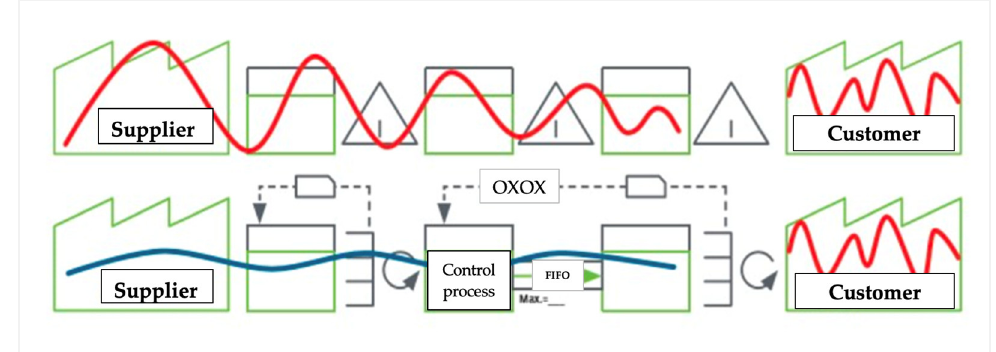
Figure 7. Value stream before and after implementation of lean manufacturing tools. Source: Authors’ compilation.